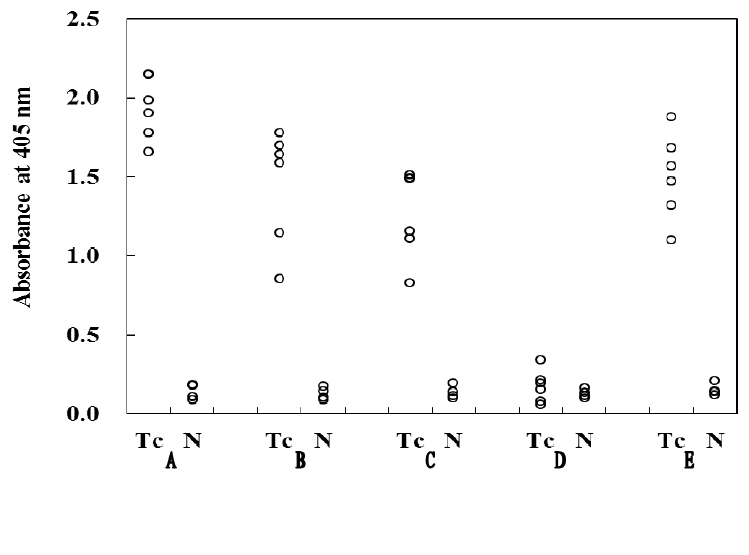
Figure 3. ELISA reaction between human sera and synthesized oligosaccharides A – E . Tc: toxocariasis patient group; N: normal healthy